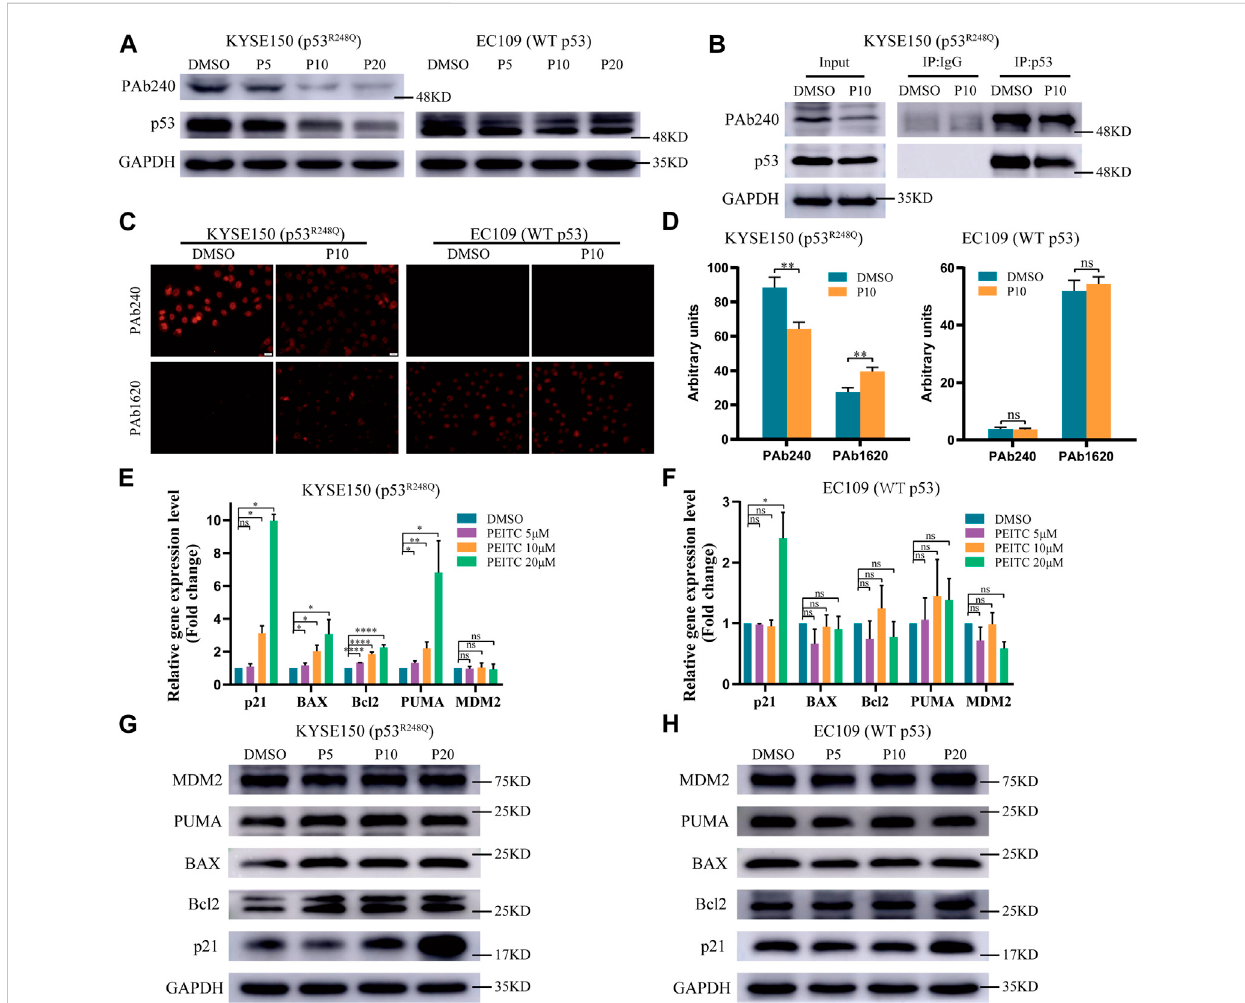
FIGURE 2 PEITC inducesconformational changesinthep53 R248Q mutantproteinandrestoresitstransactivation function. (A,GandH) Theexpressionlevels of p53,PAb240,p21,Bcl2,BAX,PUMA,MDM2andGAPDHproteinsweremeasuredbyWesternblotanalysis. (B) ExtractsofcellstreatedwithDMSOorPEITC for24hweresubjectedtop53immunoprecipitation,andthentoimmunoblotting. (C) Immuno fl uorescenceofthecellswasperformedusingPAb240and PAb1620 antibodies. (D) Quanti fi cation of PAb240 and PAb1620 staining shown in panel (C) . (E, F) RT-qPCR of p53-regulated genes in cells treated with DMSO or PEITC for 24 h * p < 0.05; ** p < 0.01; **** p < 0.0001. P5, PEITC 5 μ M; P10, PEITC 10 μ M; P20, PEITC 20 μ M. The cell experiment was repeated three